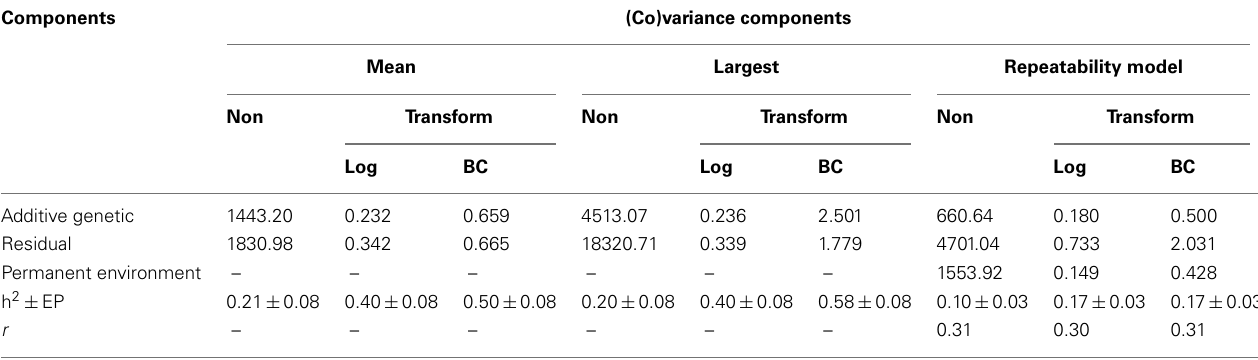
Table 3 |Additive genetic, residual (co)variance and heritabilities estimates, obtained using non-transformed (Non) and log and Box–Cox (BC) transformed data forAngus